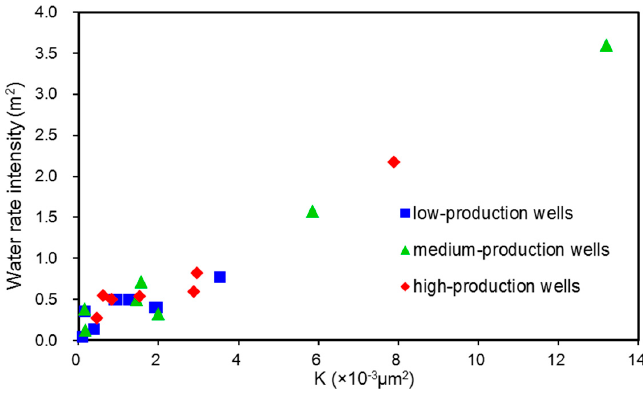
Figure 11. The relation between water rate intensity and permeability in water drainage stage.